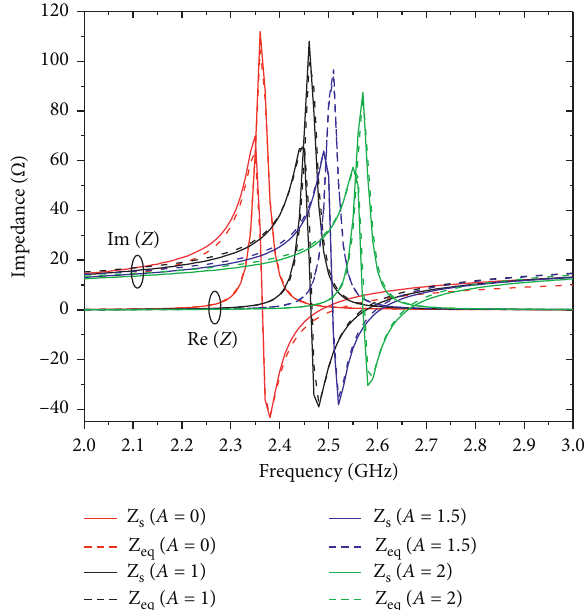
Figure 10: Input impedance from the optimized circuit parameters compared with the simulation results for the four cases with A � 0 (the flat case), 1 mm, 1.5 mm, and 2mm.